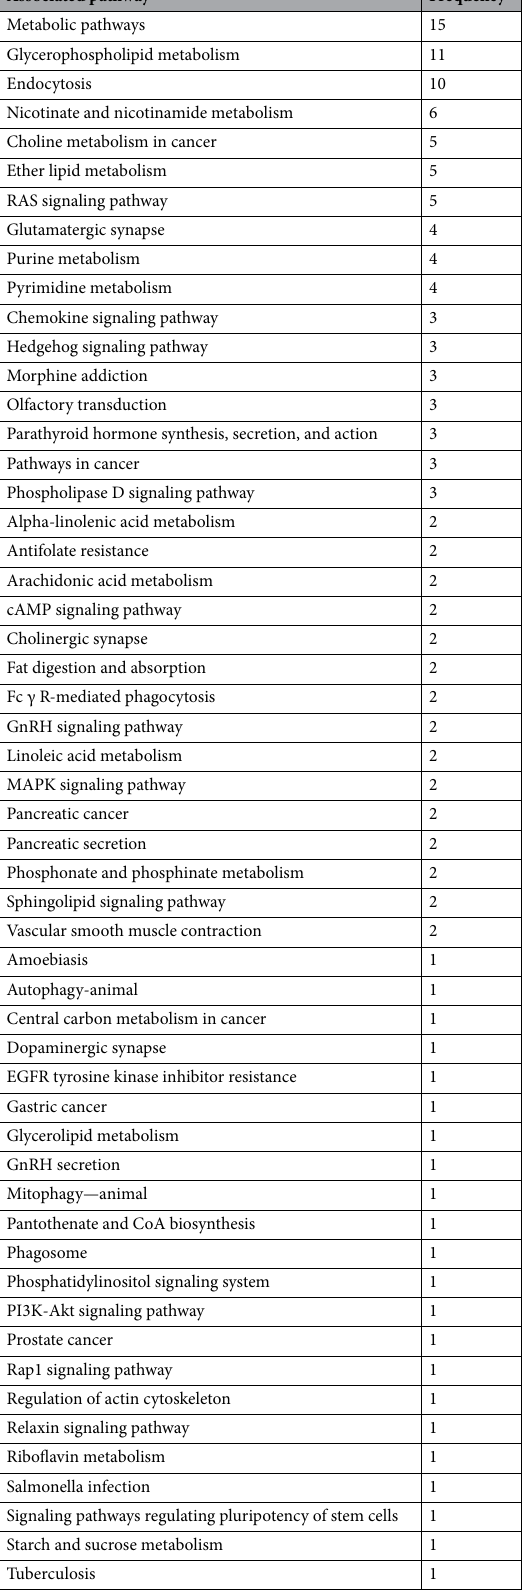
Table 4. Associated pathways of 20 vital medicinal herbs. Sorted by the frequency of pathways presented in Table 3. GnRH gonadotropin-releasing